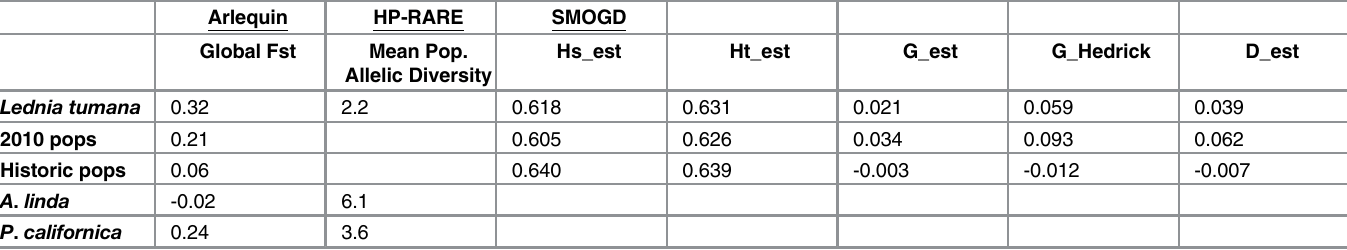
Table 2. Summary of results from population genetic analyses.